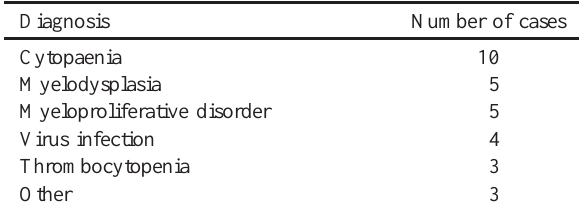
Table 1 Underlying diagnoses in bone marrow trephines containing lymphoid aggregates but showing no evidence of